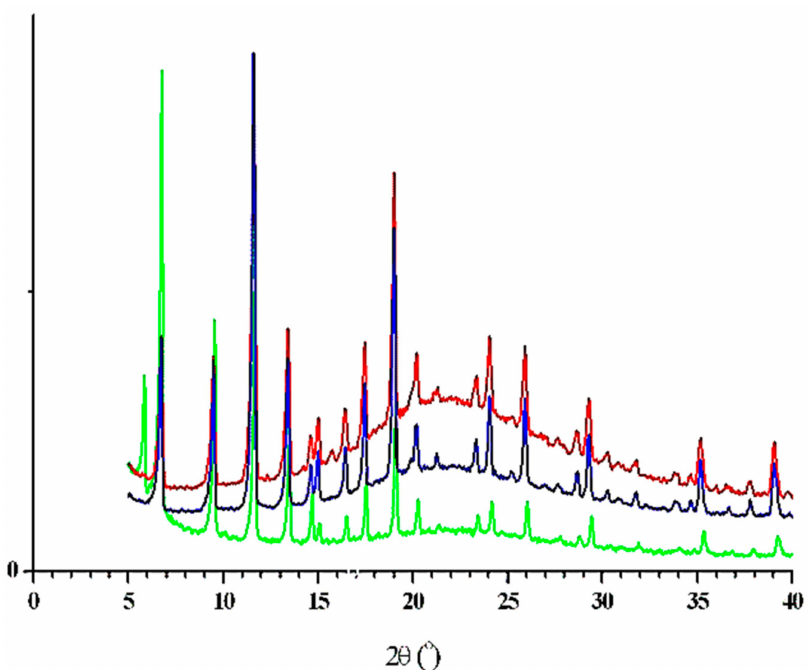
Figure 3. The combined presentation of the XRD patterns of the 1 (green), 2 (blue), and 3 (red)